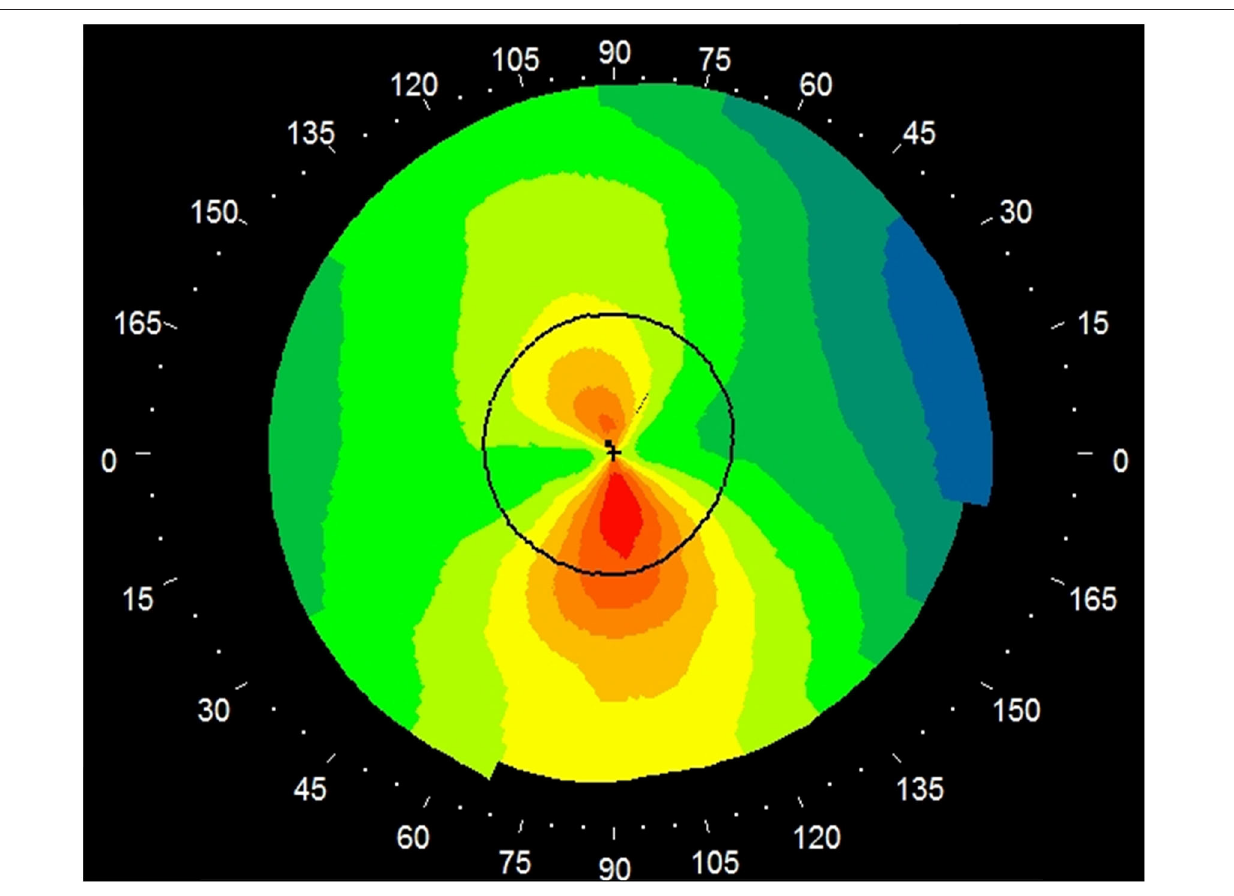
(sensitivity 0.611, specificity 0.966 for Grade 1, sensitivity 0.615, specificity 0.912 for Grade 2, sensitivity 0.281, specificity 0.957 for Grade 3, and sensitivity 0.640, specificity 0.950 for Grade 4) in classifying the stage of the disease. Figure 2 shows the receiver operating characteristic curves of classifying normal and Grade 1 to 4 keratoconic eyes, and the AUC value was 0.997, 0.955, 0.899, 0.888, and 0.943 as Grade 0 (normal) to 4 grading tests,